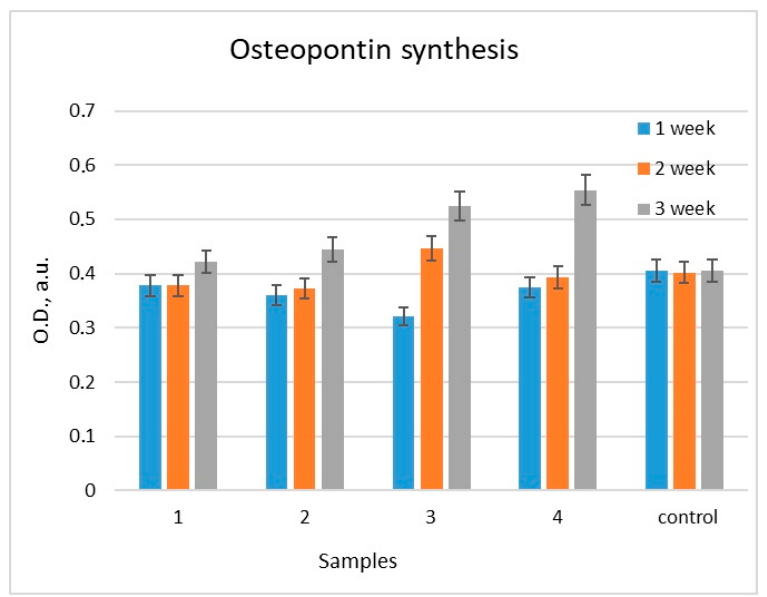
Figure 11. The content of osteopontin in the medium conditioned by MG-63 cells during differentiation in the osteogenic direction. (Note: Control is the cultivation of cells on the surface of plastic. The level of osteopontin in the medium from control cells was taken as 100% [cultivation on plastic].)